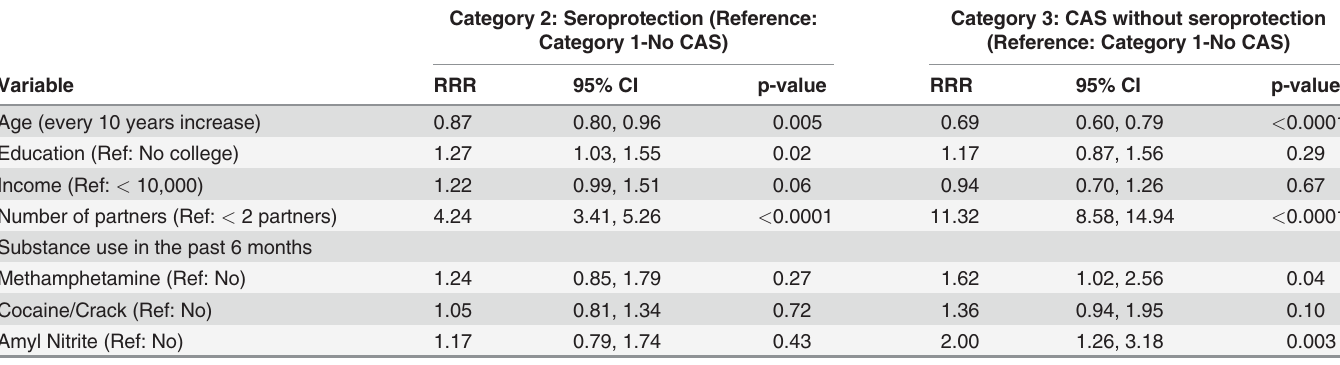
Table 2. Multinomial logistic regression of covariates with sexual behavior (includes all visits) 1 .